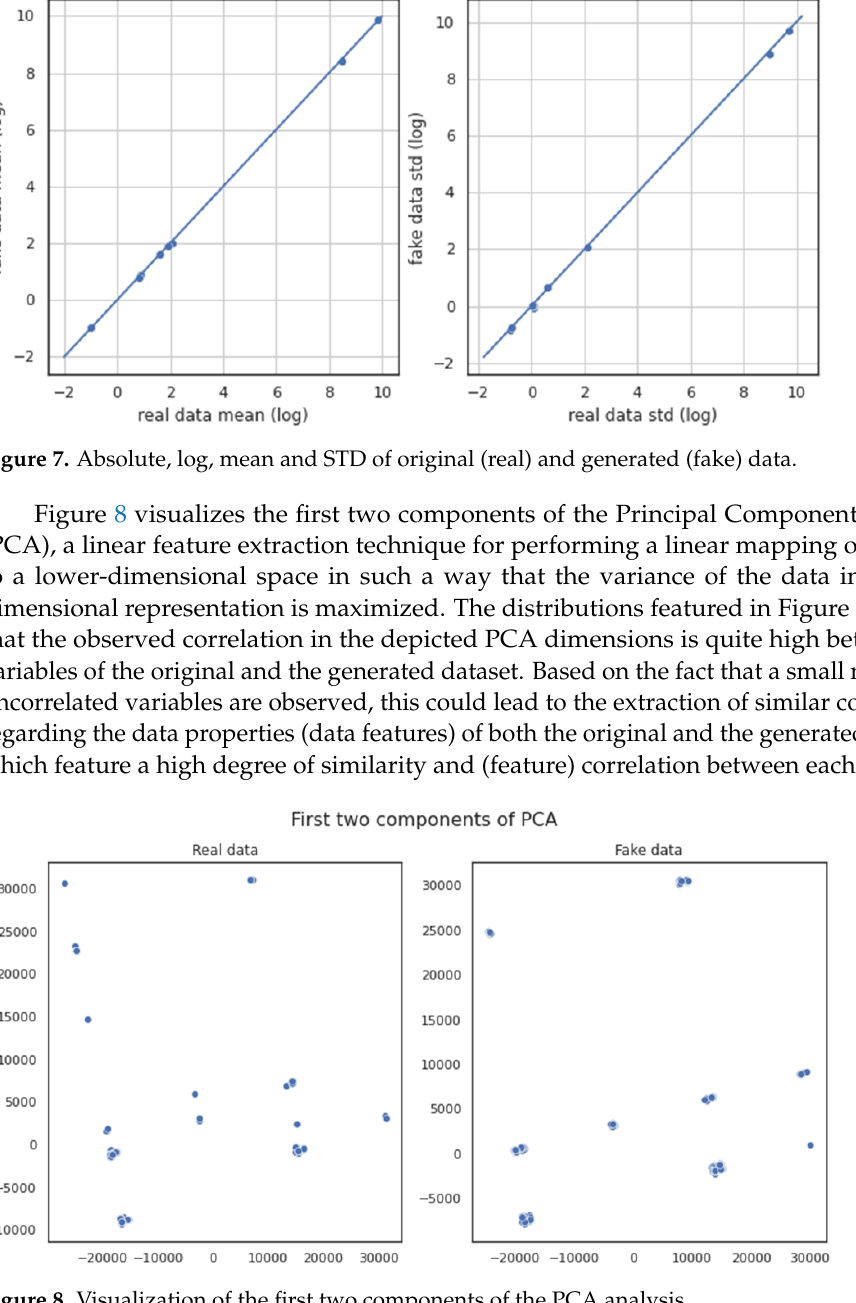
Figure 8. Visualization of the first two components of the PCA analysis.